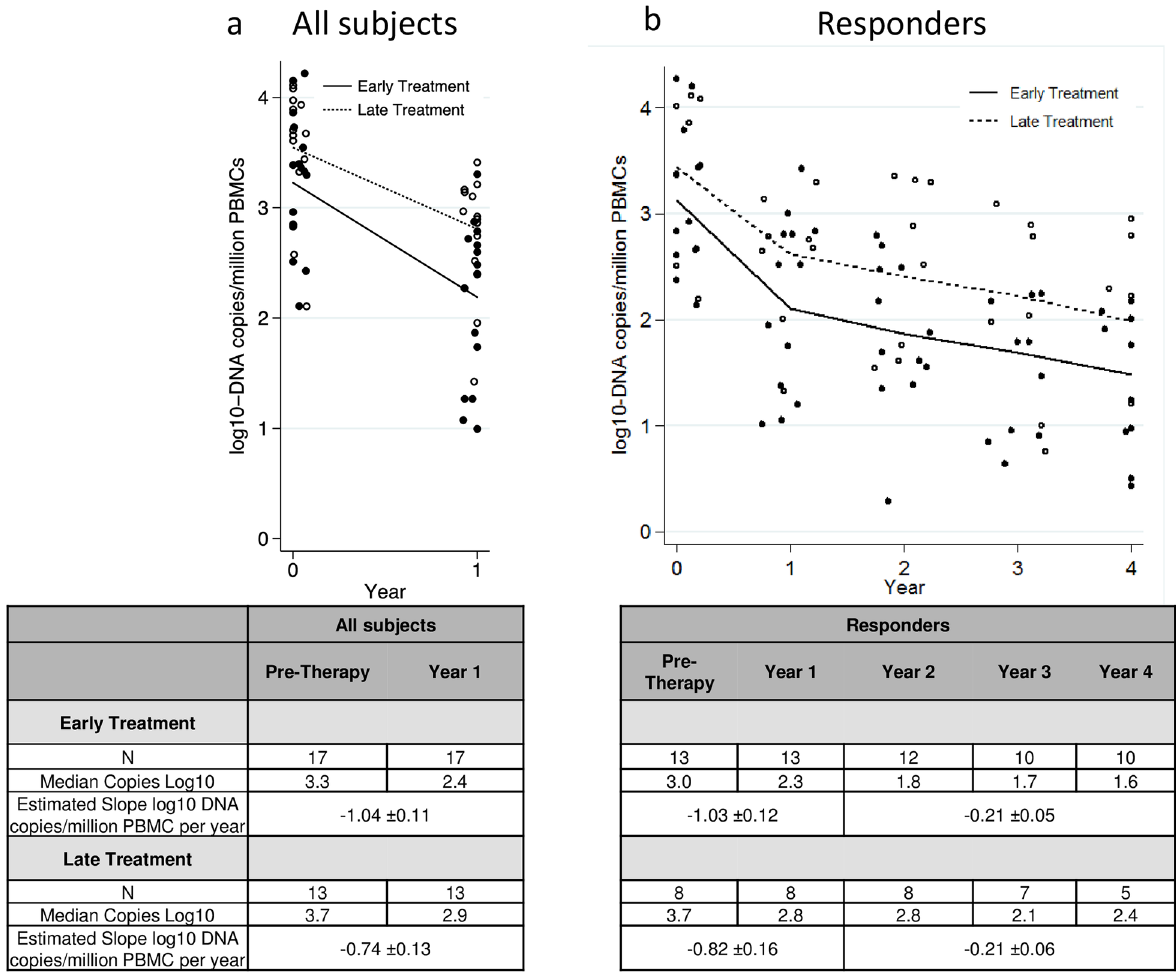
Fig 2. Estimation of PBMC HIV-1 DNA Decline. a) Estimation of PBMC HIV-1 DNA Decline in All Children over the First Year of cART . ET (closed circle and solid line) and LT children (open circle and dashed line) experienced a significant decline in PBMC HIV-1 DNA after one year of cART (-1.04 ± 0.11 log 10 DNA copies per million PBMC, p < 0.001 in ET and -0.74 ± 0.13 log 10 DNA copies per million PBMC, p < 0.001 in LT). b) Estimation of PBMC HIV-1 DNA Decline in Children with Controlled HIV-1 Replication . ET (closed circle and solid line) and LT children (open circle and dashed line) experienced a marked decline in PBMC HIV-1 DNA levels in the first year of cART (-1.03 ± 0.12 log 10 , p < 0.001 in ET and -0.82 ± 0.16 log 10 , p < 0.001 in LT), but the rates of decline did not differ significantly between ET and LT (p = 0.3). Similarly, in years 1 through 4 of cART, PBMC HIV-1 DNA levels continued to decline significantly in both the ET (p < 0.001) and LT groups (p < 0.001), but the decline slopes were not statistically significantly different between the